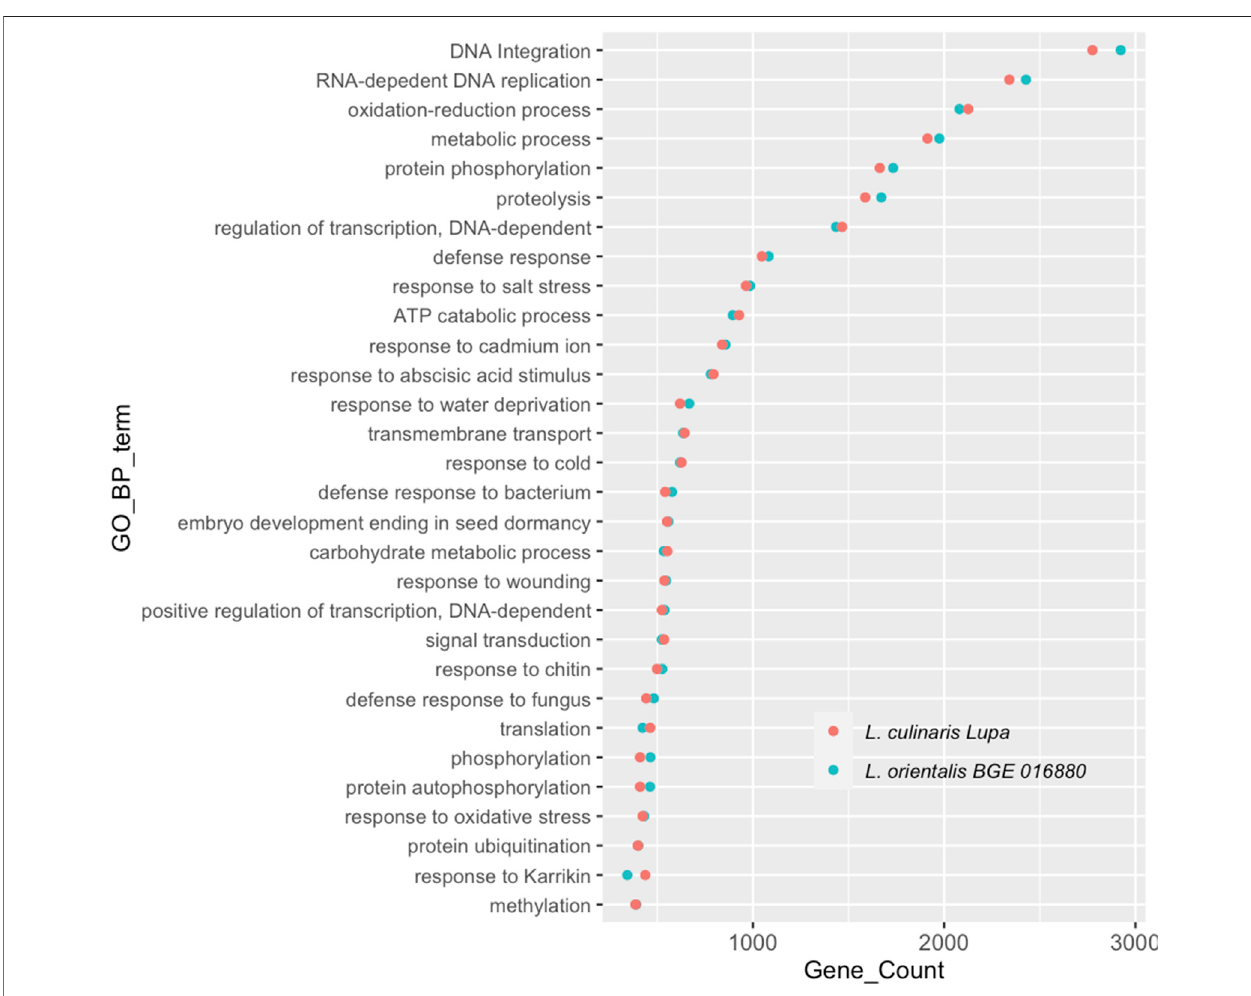
FIGURE1| Top30geneontologytermsinthebiologicalprocess(GO-BP)assignedtogenesfrom denovo -assembledtranscriptomesof L.orientalis BGE016880 and L. culinaris cv Lupa. X -axis represents correspondent number of genes for each GO-BP term.